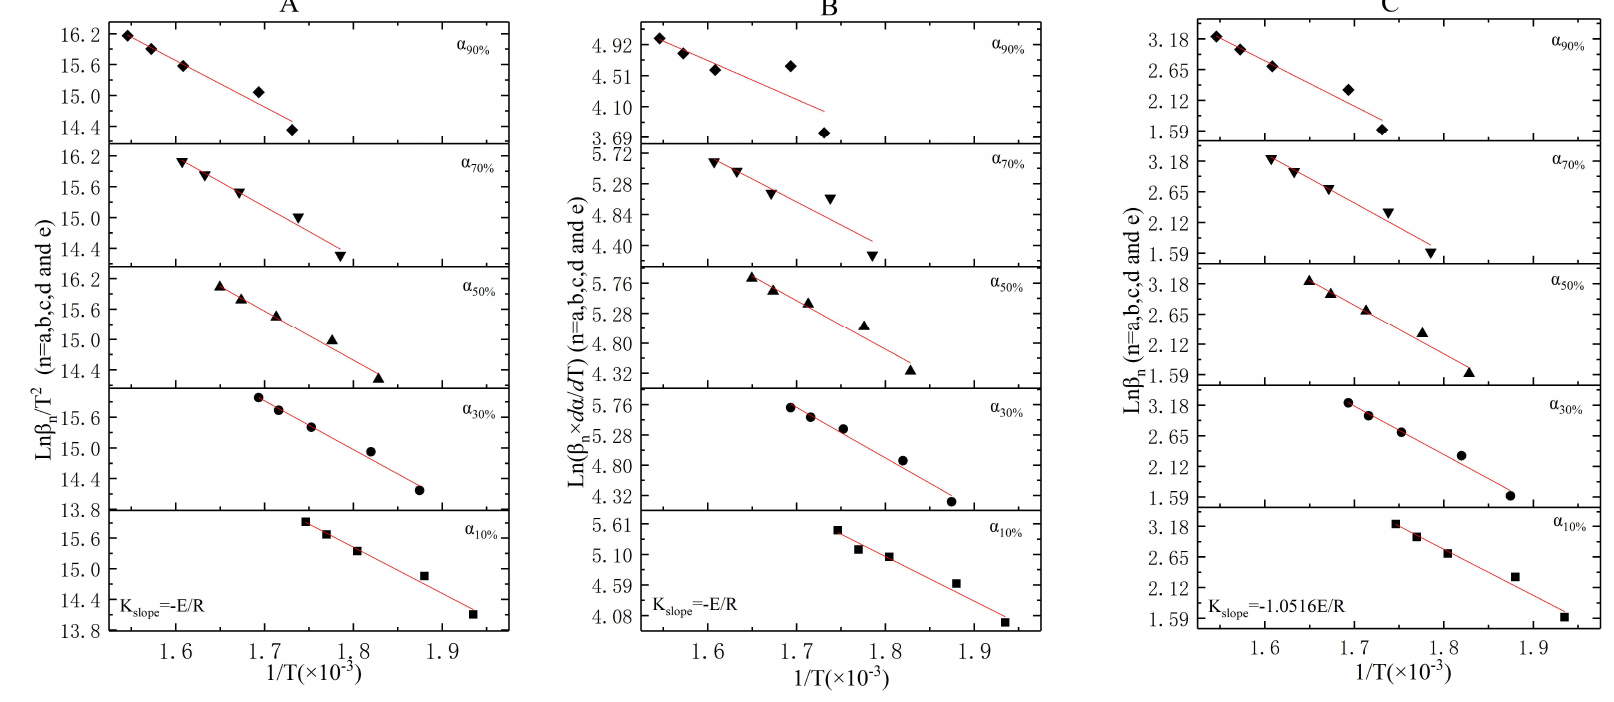
Figure 4 . The linear fitting results for Stage 2 under the KAS, Friedman, and FWO methods ( A —KAS method, B —Friedman method, and C —FWO method).